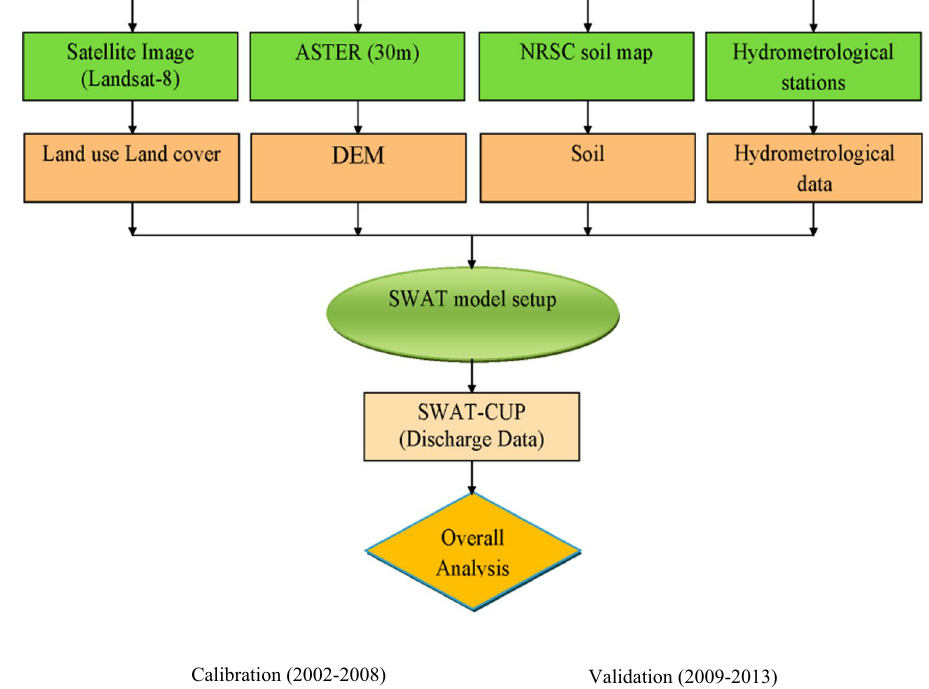
Fig. 8 Observed and simulated monthly flows at Neemsar